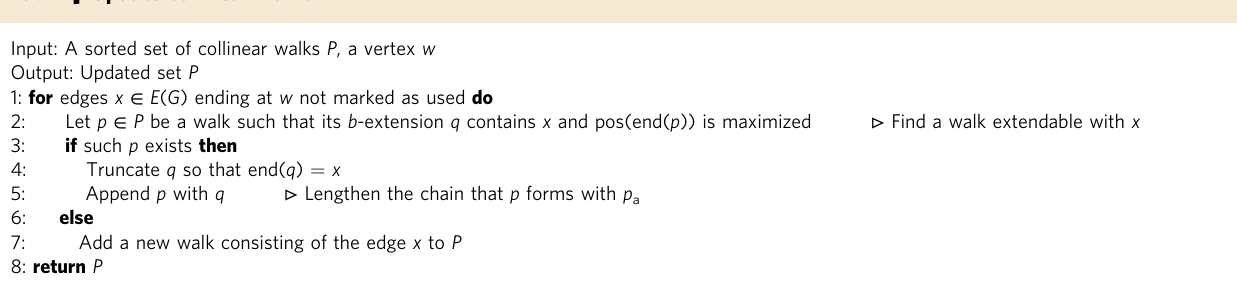
Box 2 | Update-collinear-walks